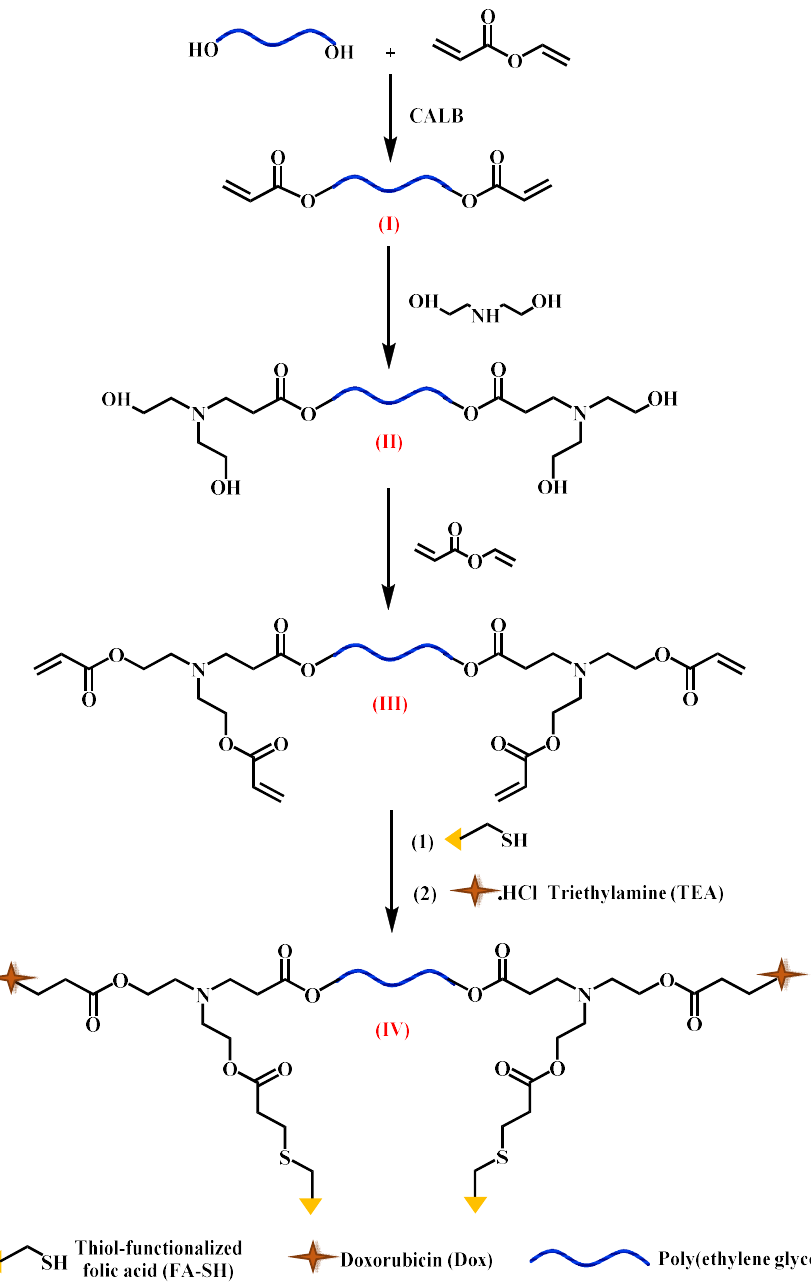
Figure 1. Strategy for the synthesis of FA 2 -dPEG-DOX 2.